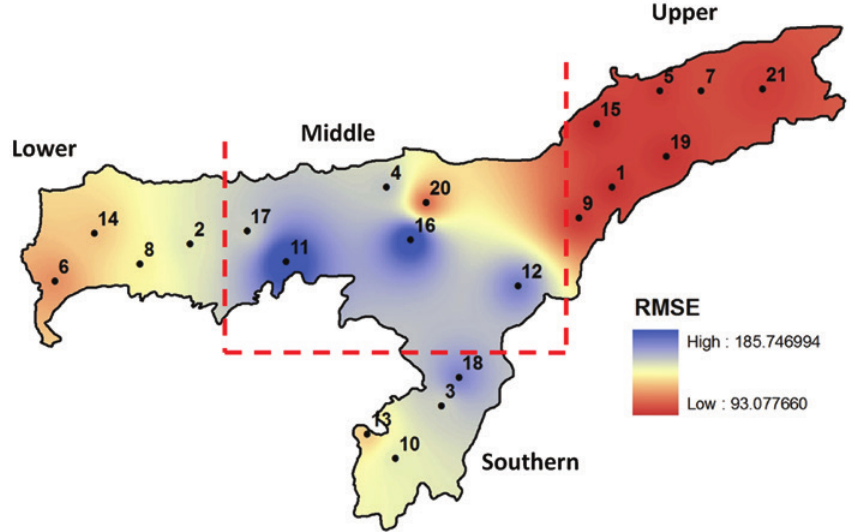
Figure 7: Map Showing the Distribution of RMSEs for the WR2 Model over Assam.